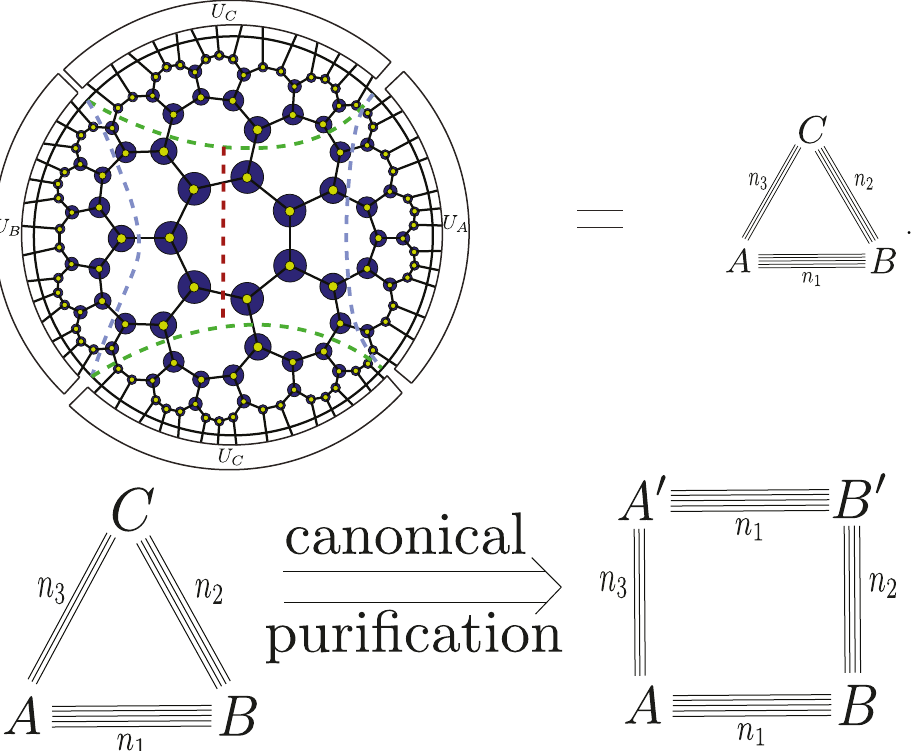
Figure 5 . After applying local unitaries, the RSTN drastically simpli(cid:12)es to a combination of Bell pairs shared by the three parties. The Bell pairs then lead to a simple canonically puri(cid:12)ed